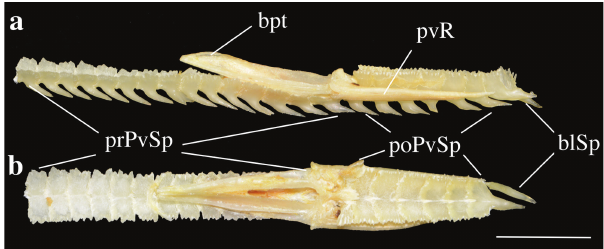
Fig. 2. Metynnis melanogrammus , INPA 18457, 144.8 mm SL. Abdominal spines: a . left lateral view; b. dorsal view. blSp , bilateral spine; bpt , basipterygium; poPvSp , post- pelvic spines; prPvSp , prepelvic spines; pvR , pelvic-fin rays. Scale bars: 10 mm.